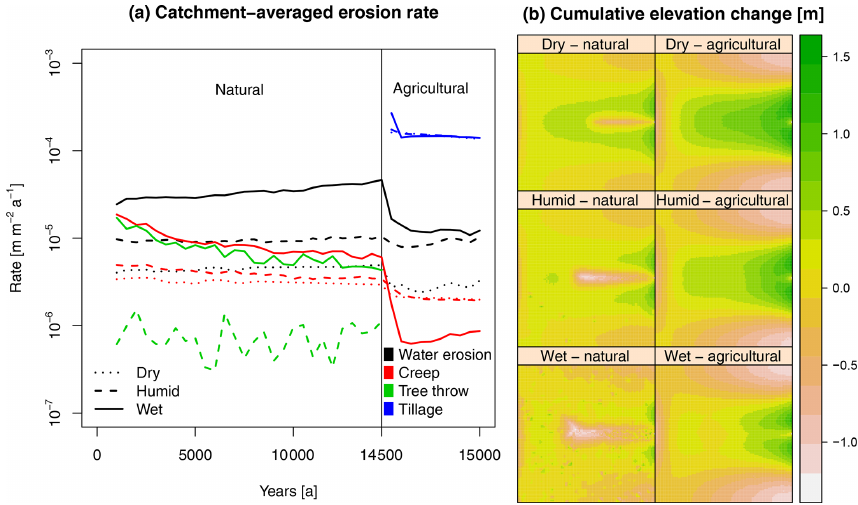
Figure 5. (a) Average erosion rates throughout the catchment for the different geomorphic processes over time. The colors represent different geomorphic processes, and the line types represent different rainfall scenarios. Note that the y axis is log scaled. (b) Cumulative elevation change at the end of the natural and agricultural phase compared to the initial DEM for the different rainfall